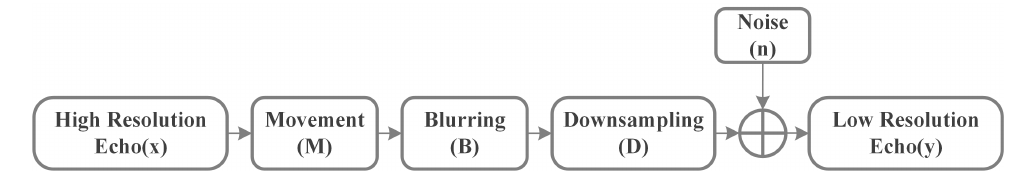
Figure 2. Weather radar degradation